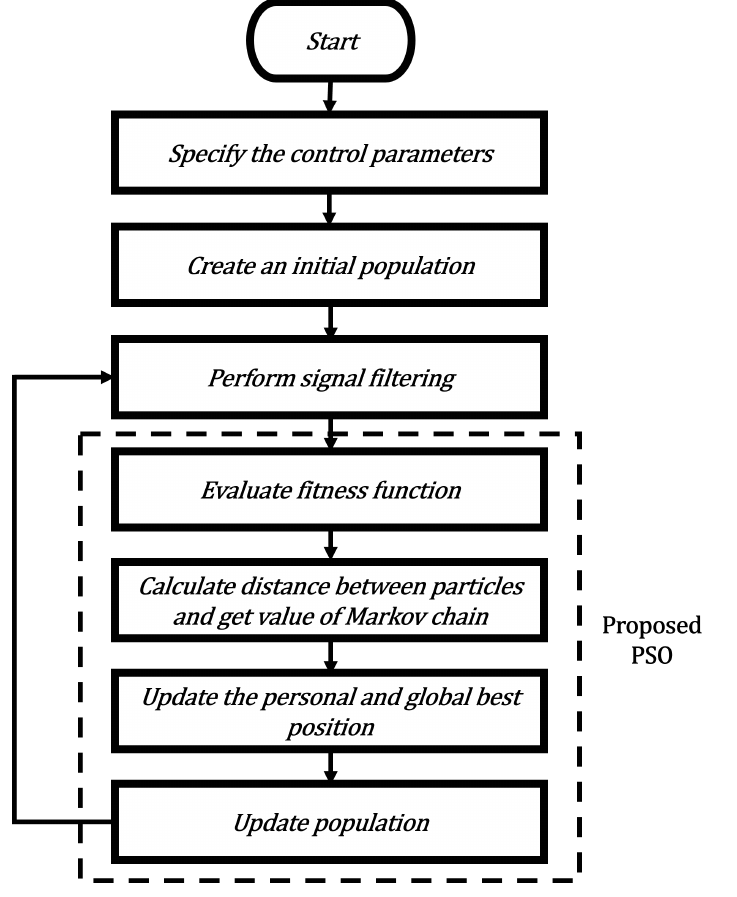
Figure 2. Flowchart of the proposed Markov switching PSO